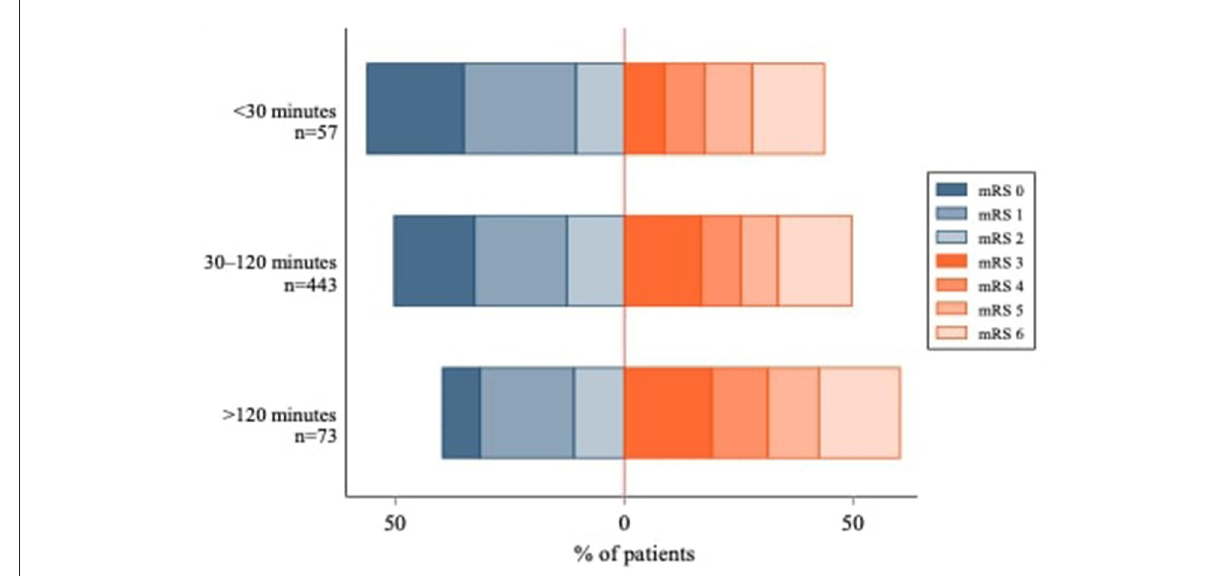
FIGURE2 Modified Rankin Scale Score Distribution at 90 days by IVT-ET time delay group. The IVT-ET time delay corresponds to the elapsed time between intravenous thrombolysis (IVT) and endovascular thrombectomy (ET). 90-day mRS scores were not available for 141 patients.